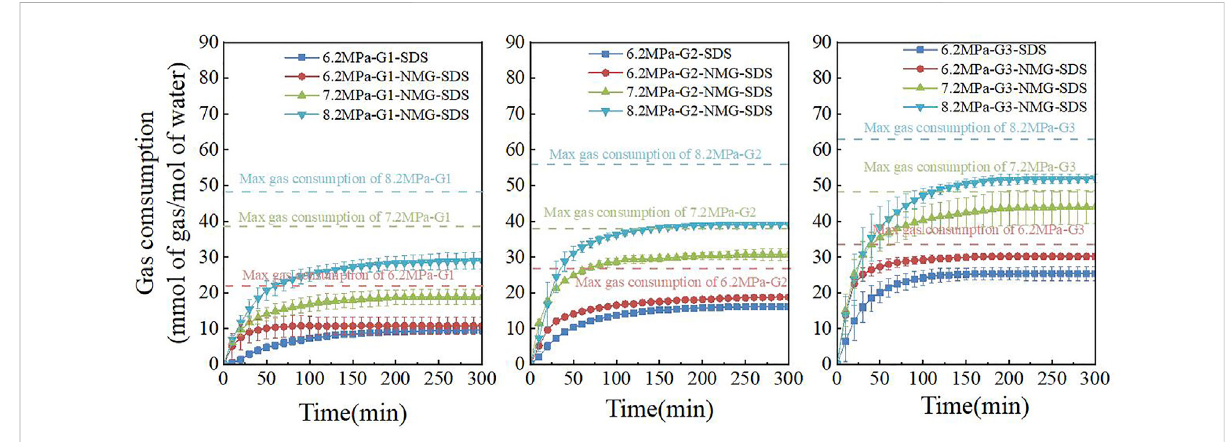
FIGURE 5 Gas consumption during gas hydration of different gas components under different systems.